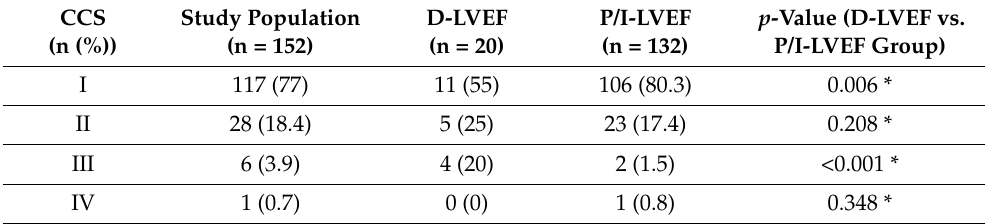
Table 6. Relationship between LVEF change and CCS class grade in the follow-up.